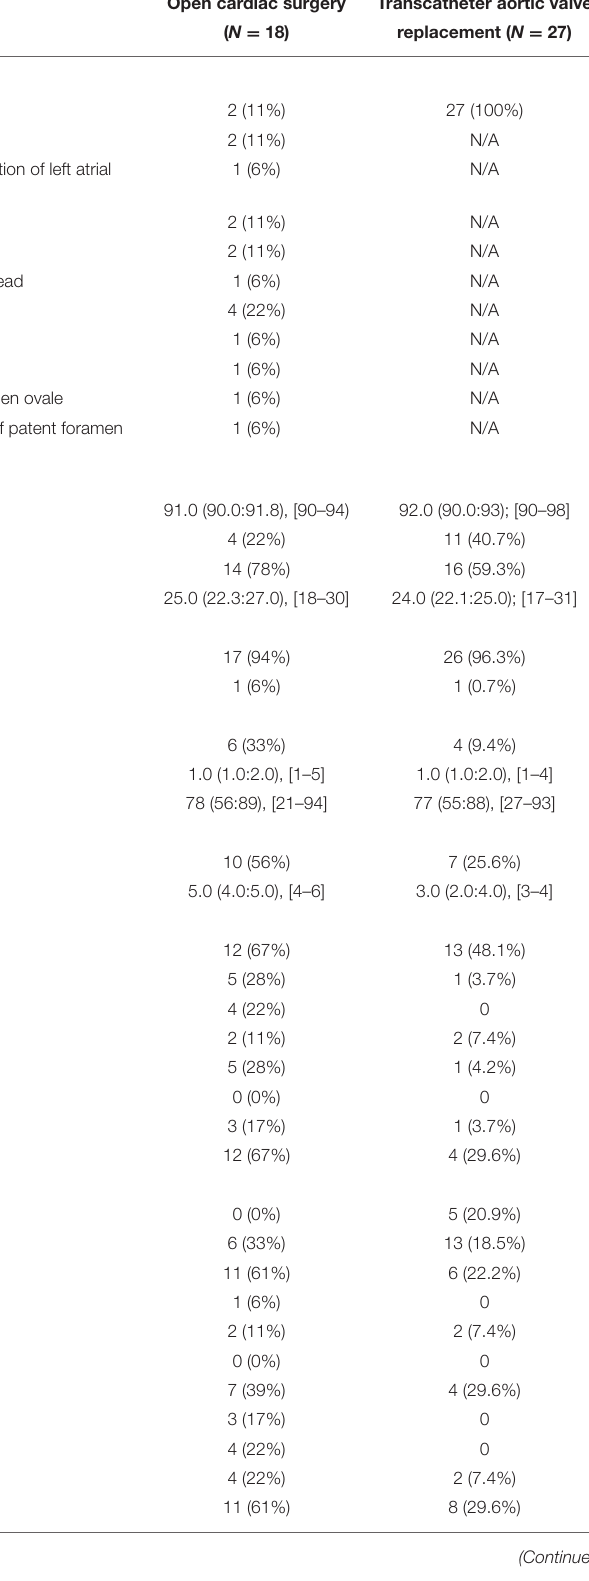
TABLE 1 | Demographics and comorbidities of nonagenarians undergoing open cardiac surgery via a sternotomy and transcatheter aortic valve replacement.